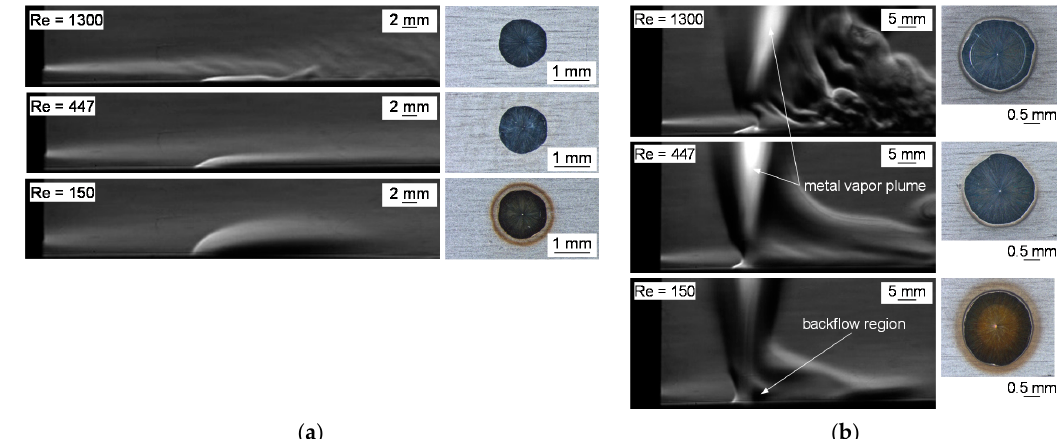
Figure 10. Schlieren images at a distance to nozzle of 20 mm for different Re to consider the effect on shielding gas coverage for: ( a ) heat conduction welding; ( b ) deep penetration welding.